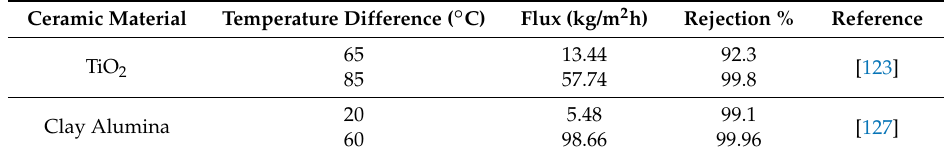
Table 4. Summary of studies related to the use of ceramic membranes in membrane distillation (MD) applications.